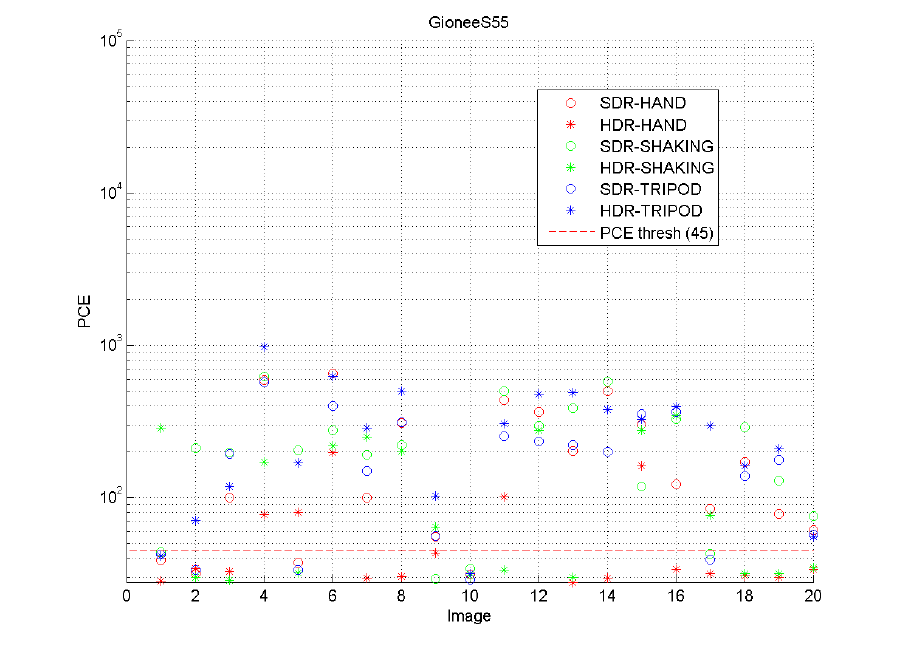
Figure 10. Example of the result obtained correlating noise from HDR images captured by A01 with the SDR image